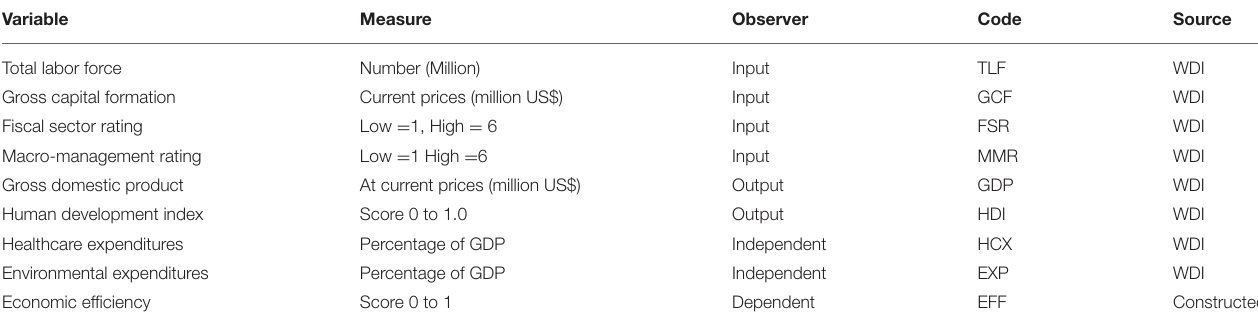
TABLE 1 | Variable, measure, and source.